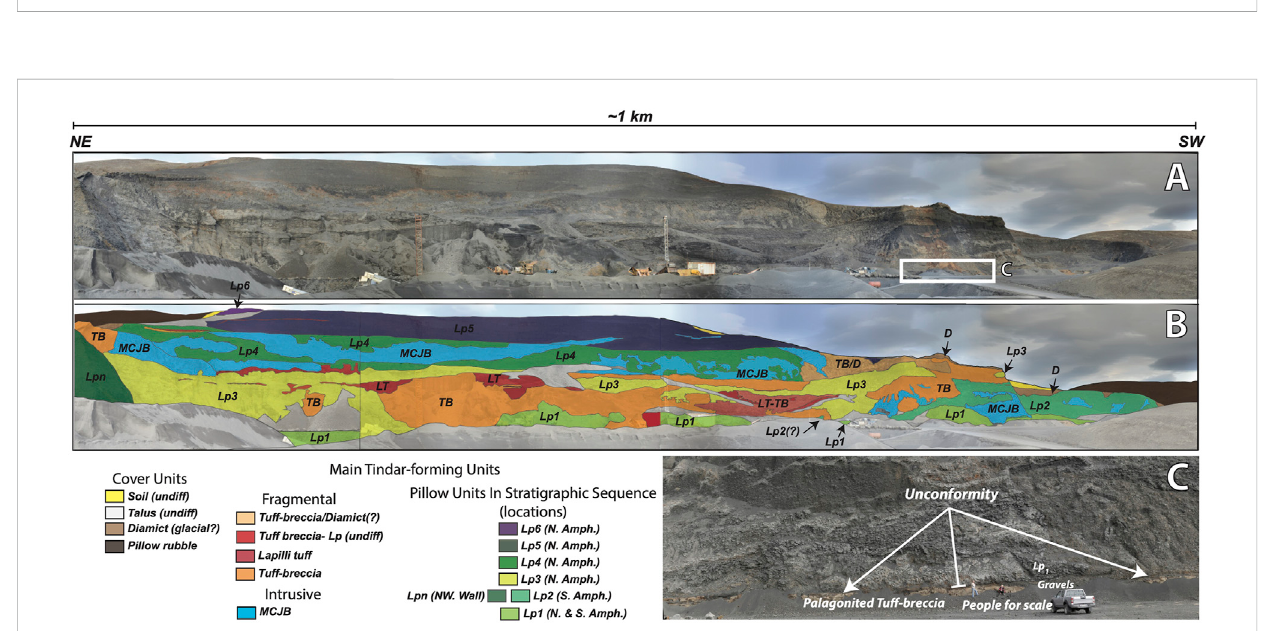
FIGURE 3 Stratigraphy of units at Vatnsskarð quarry. (A) Composited image of the quarry with interpreted distribution of units below (B) . (C) Close-up view of the palagonitized tuff-breccia that forms the bedrock to the ridge and is unconformably overlain by quarry units.